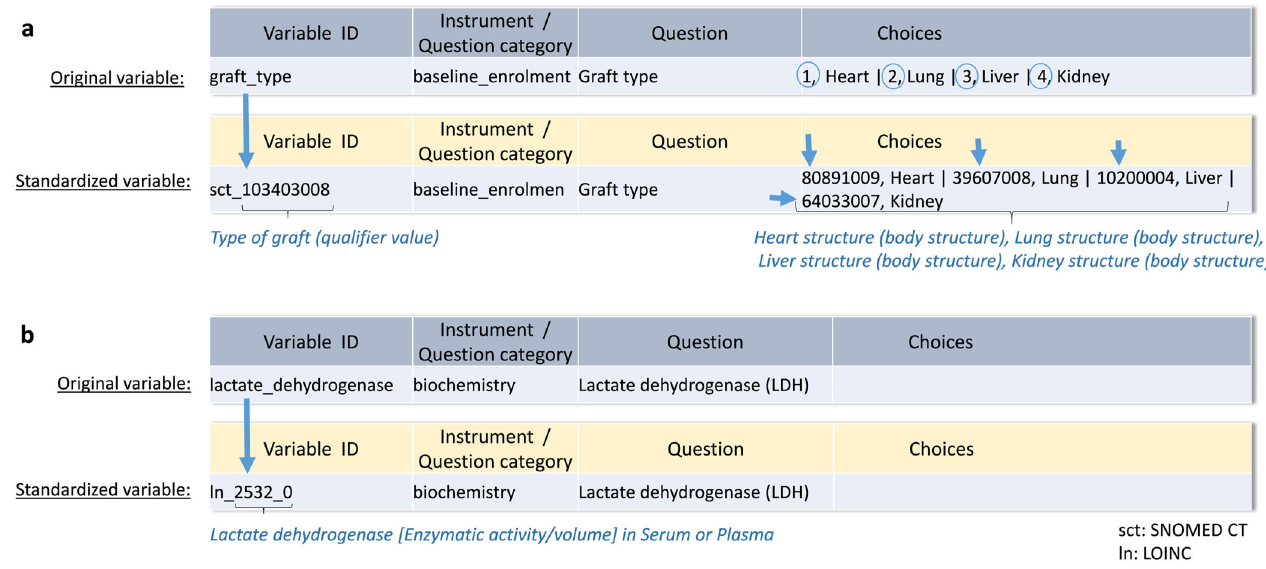
Fig. 7 Assignment of standard terminology codes to variable and answer IDs. a Assignment of SNOMED CT codes to represent the clinical concept of the question in the variable ID and the concepts contained in the answers as codes in the answer IDs. b Assignment of appropriate LOINC code representing the laboratory value lactate dehydrogenase to the variable ID of the respective question in the data